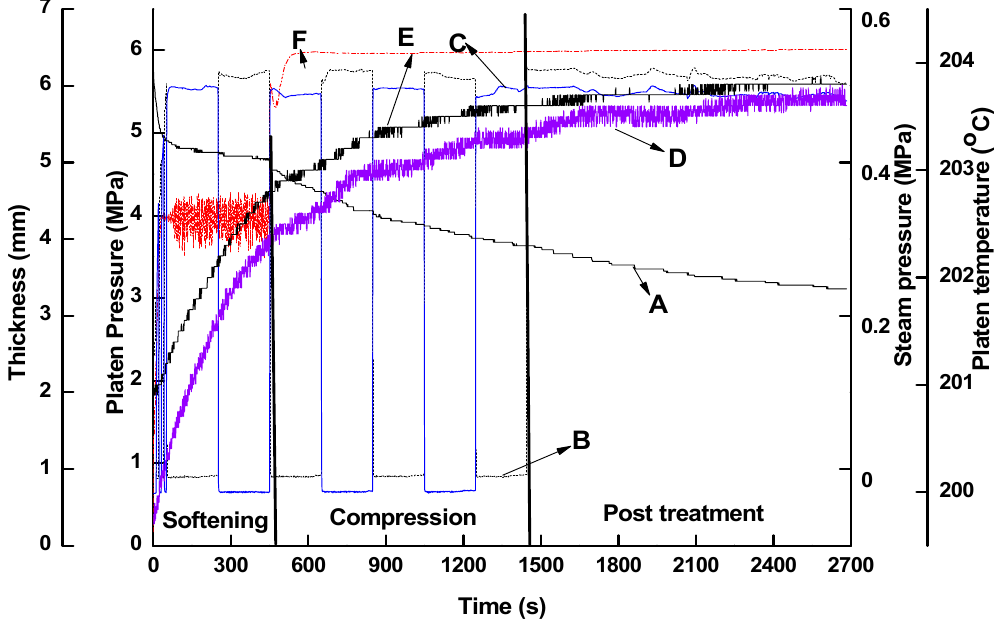
Figure 1. Thermo-hygromechanical densification process. A: Thickness; B, C: Top and bottom platen steam pressures, respectively; D, E: Top and bottom platen temperatures, respectively; F: Platen load.